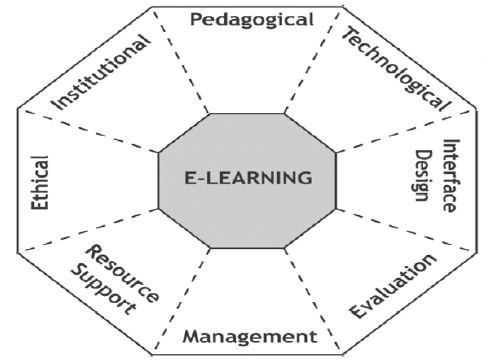
Fig 1. Khan e-learning framework (Abbaskhani et al. 2018) Various studies have been carried out on distance learning to assess the success